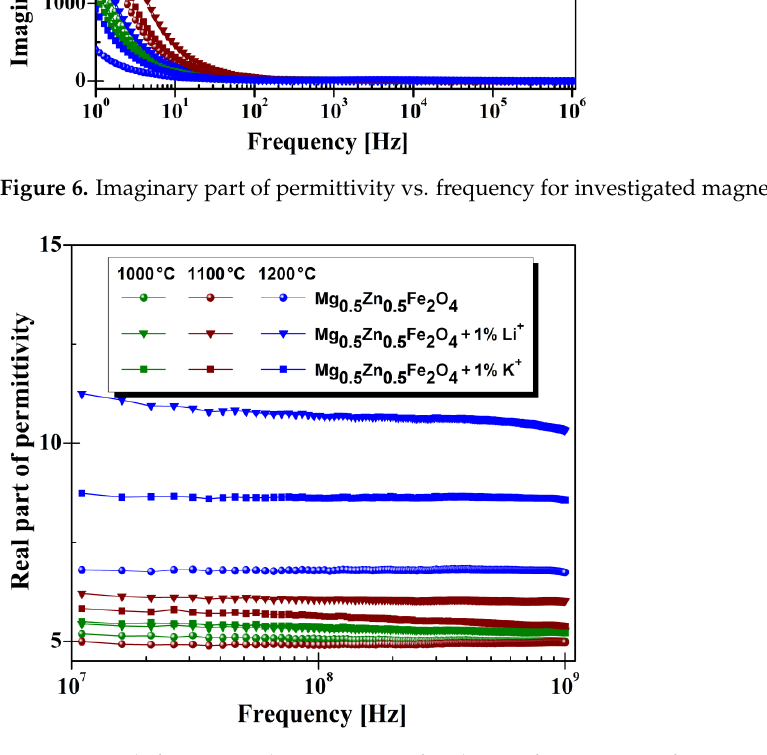
Figure 7. High-frequency characteristics of real part of permittivity for investigated Mg-Zn ferrite.